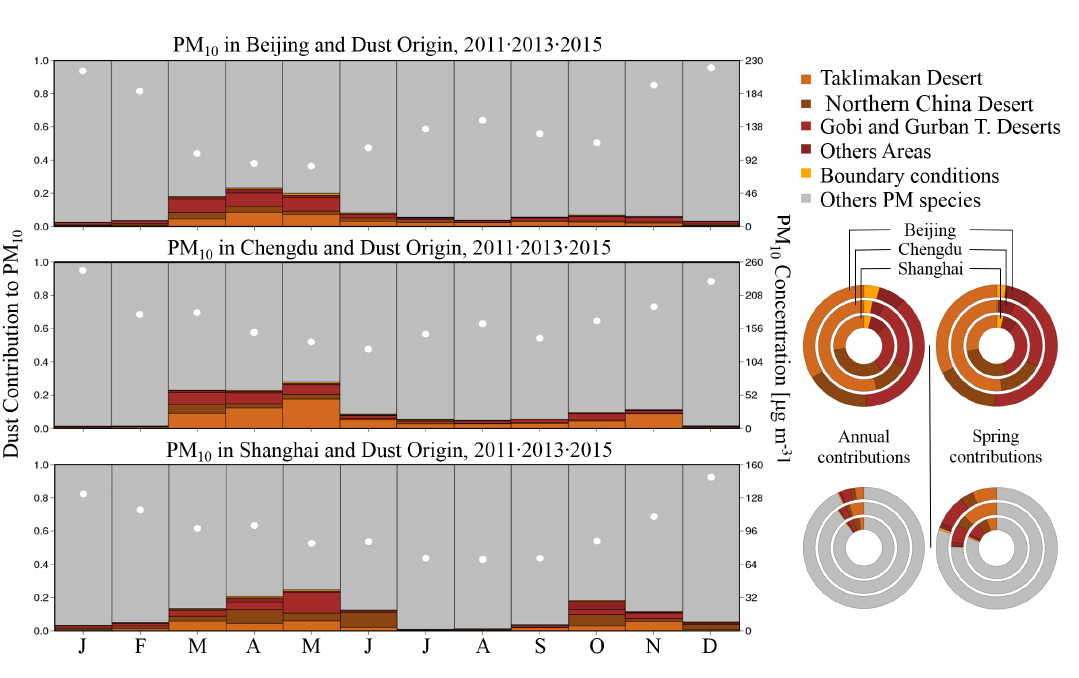
Figure 5. Dust contribution to PM 10 pollution in Beijing, Chengdu and Shanghai—Monthly variation calculated from 2011, 2013 and 2015 simulations. Ring plots show annual and spring contributors to PM 10 (bottom) and dust origin area (top) for the three cities. White dots variations in monthly PM 10 concentrations for the three